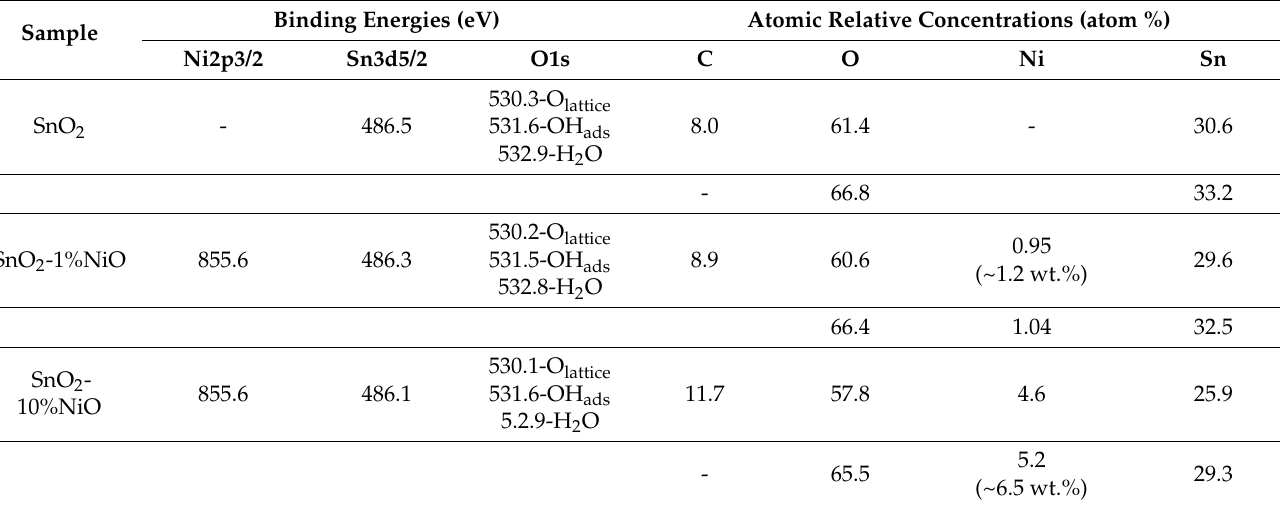
Table 1. XPS data of the investigated samples.